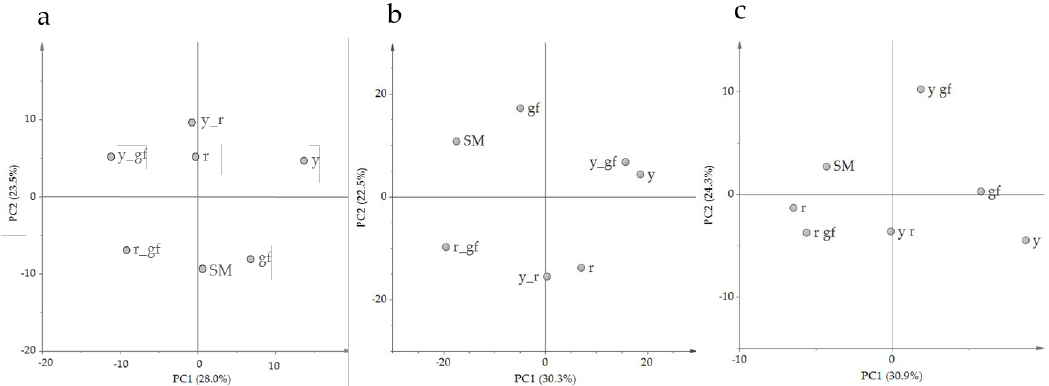
Figure 1. PC1 × PC2 score plots of the six mutated lines plus San Marzano (SM) according to relative values of 263 VOCs ( a ), 746 NP ( b ) and 110 P ( c ) metabolites measured by GC-LS and LC-HRMS. Line symbols are explained in Table